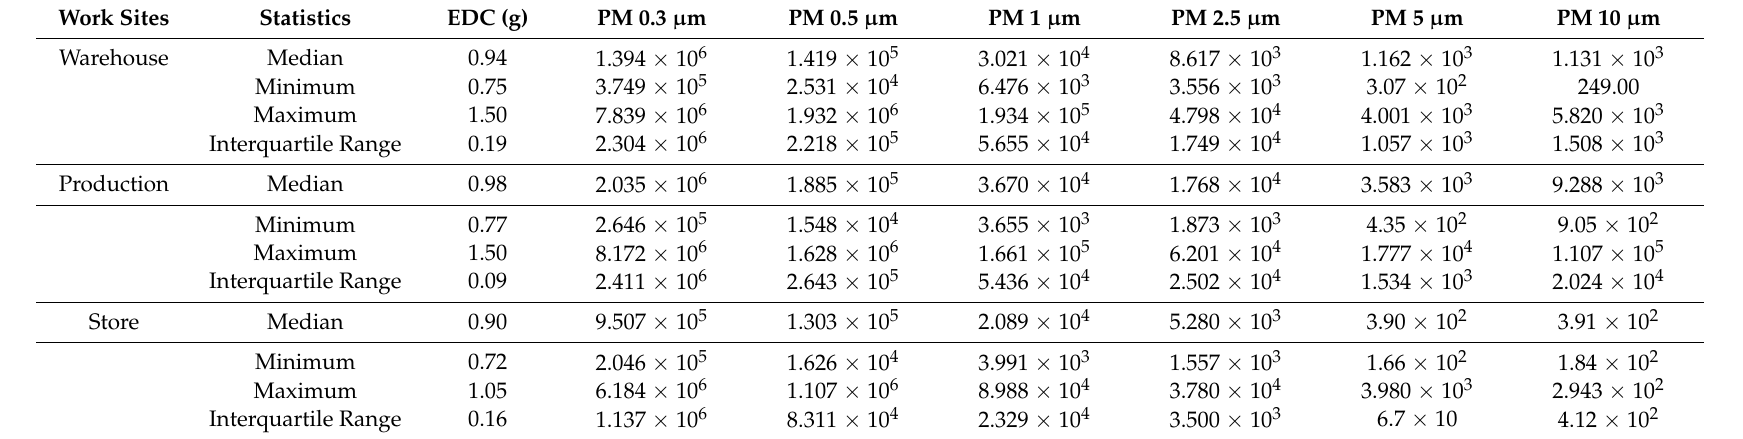
Table 2. Descriptive measures for EDC weight and particle counts of different